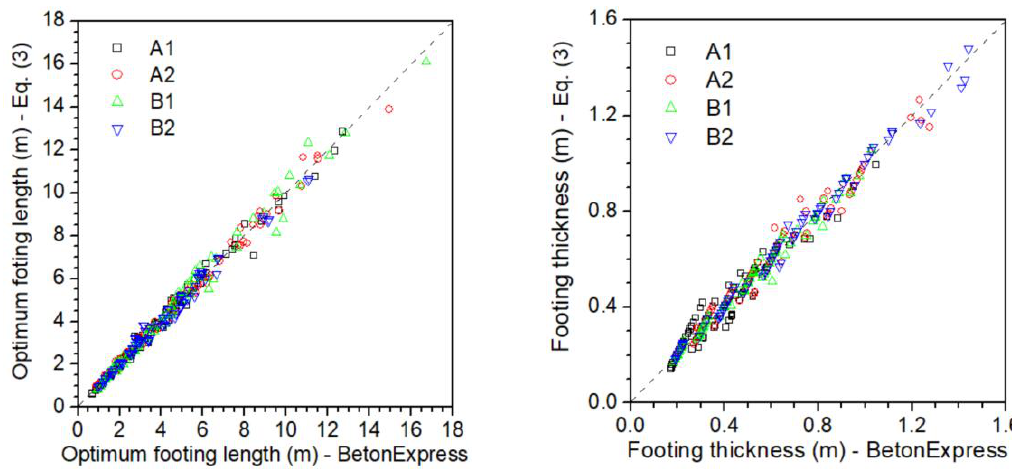
Figure 12. Optimum dimensions for retaining wall footing: Equation (3) vs. BetonExpress Figure 13. Optimum dimensions for retaining wall footing: Equation (3) vs. BetonExpress [27].